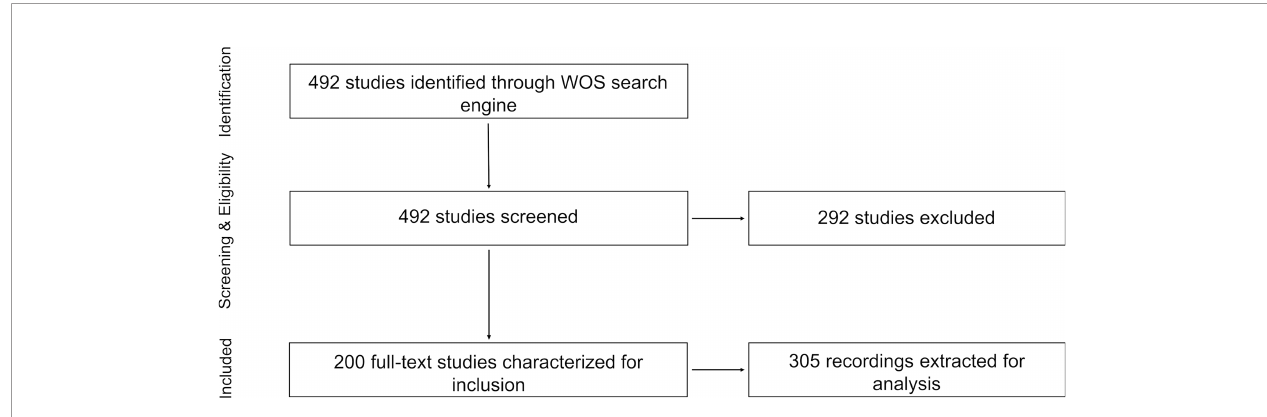
FIGURE 1 | PRISMA diagram (Moher et al., 2015) of meta-analysis